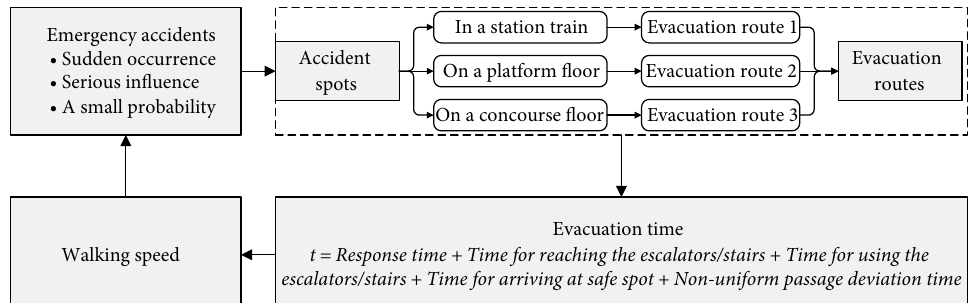
Figure 1: Theoretical CRTS emergency evacuation